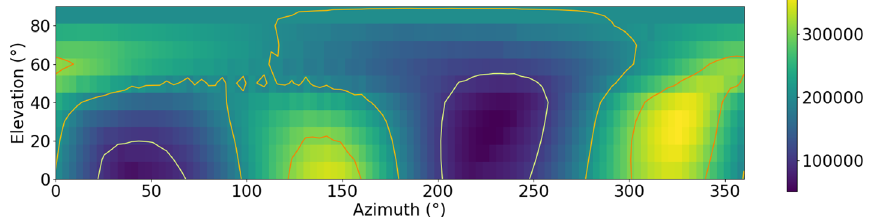
Fig. B.2. Normalized square differences between the observations (2020 green line, see Fig. 8) and the model as a function of the electron motion direction. The ground contribution is fi xed at 20% and d max = 5%. The contour shows the lines of constant cost at 1, 2, and 3 (cid:2) 10